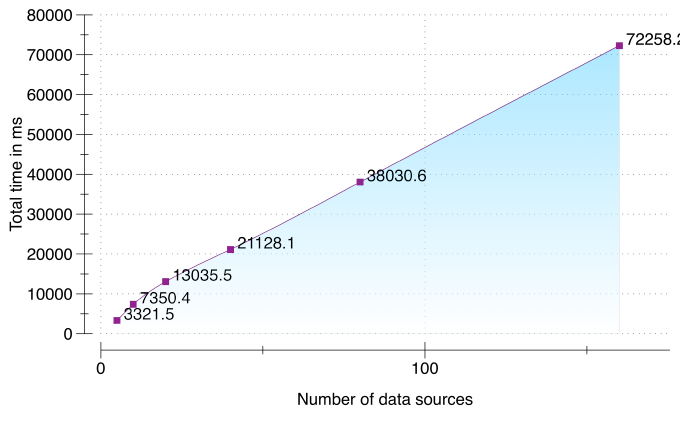
Figure 9. Scalability